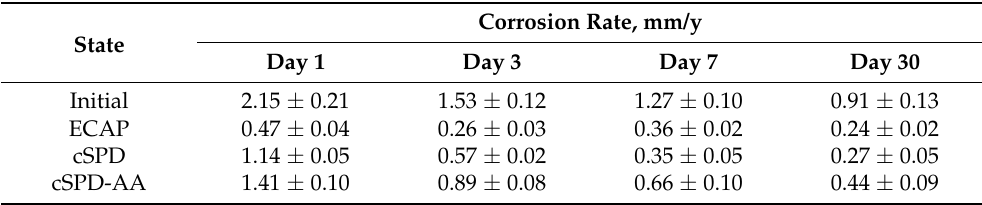
Figure 6. Images of specimens of the Mg-2Sr alloy in different structural states after immersion in Ringer’s solution over exposure time ranging from 1 to 30 days.